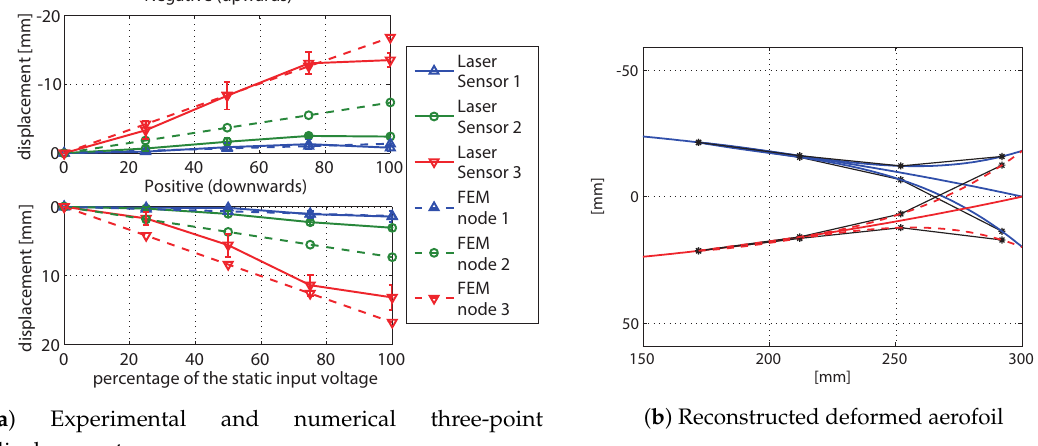
Figure 7. HBMA static displacement test.